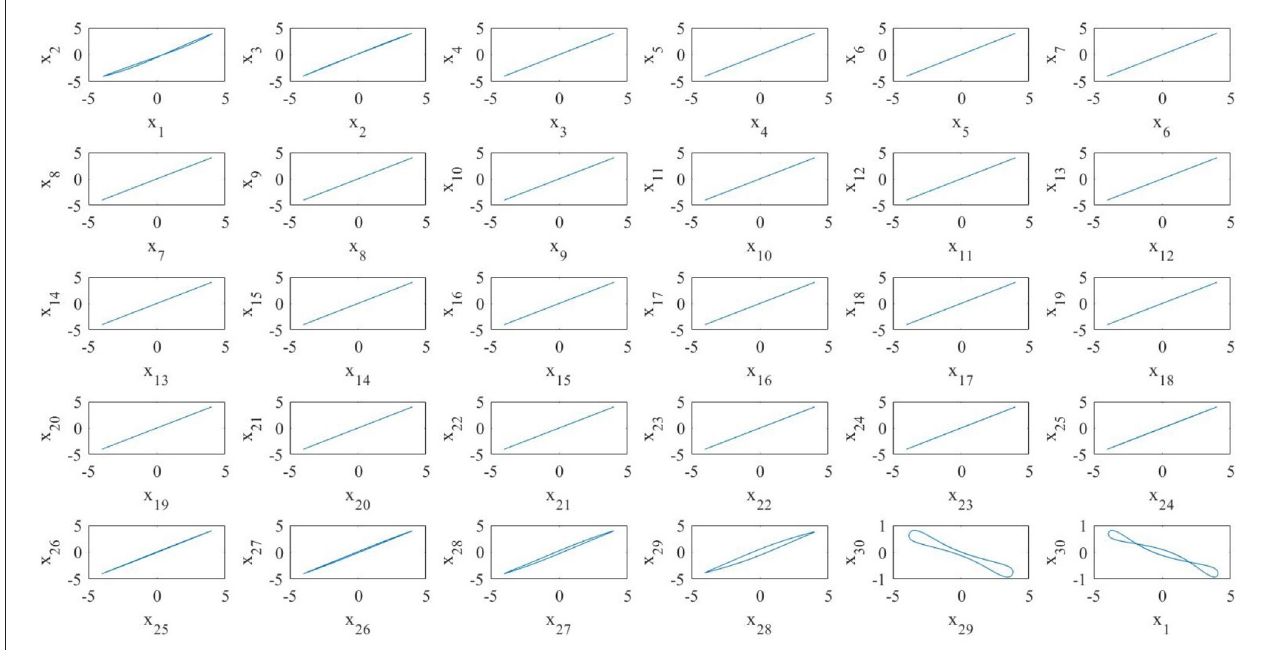
FIGURE 10 | Phase portrait of the average system of N = 30 MOCs. All the oscillators, except the last one, synchronize in